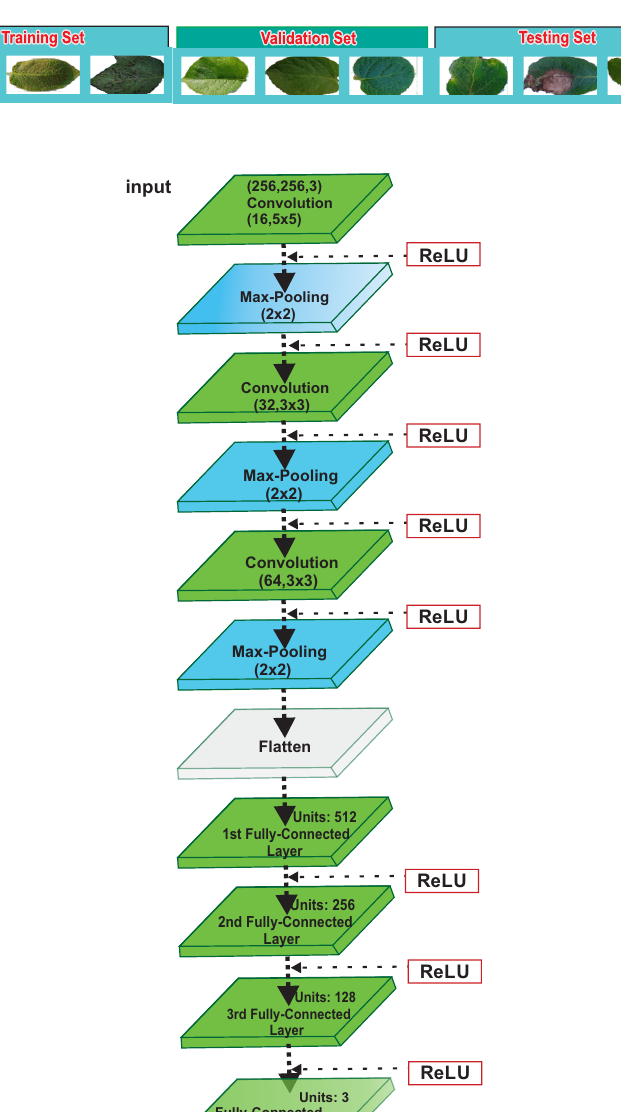
Figure 5. The architecture of the proposed PDDCNN